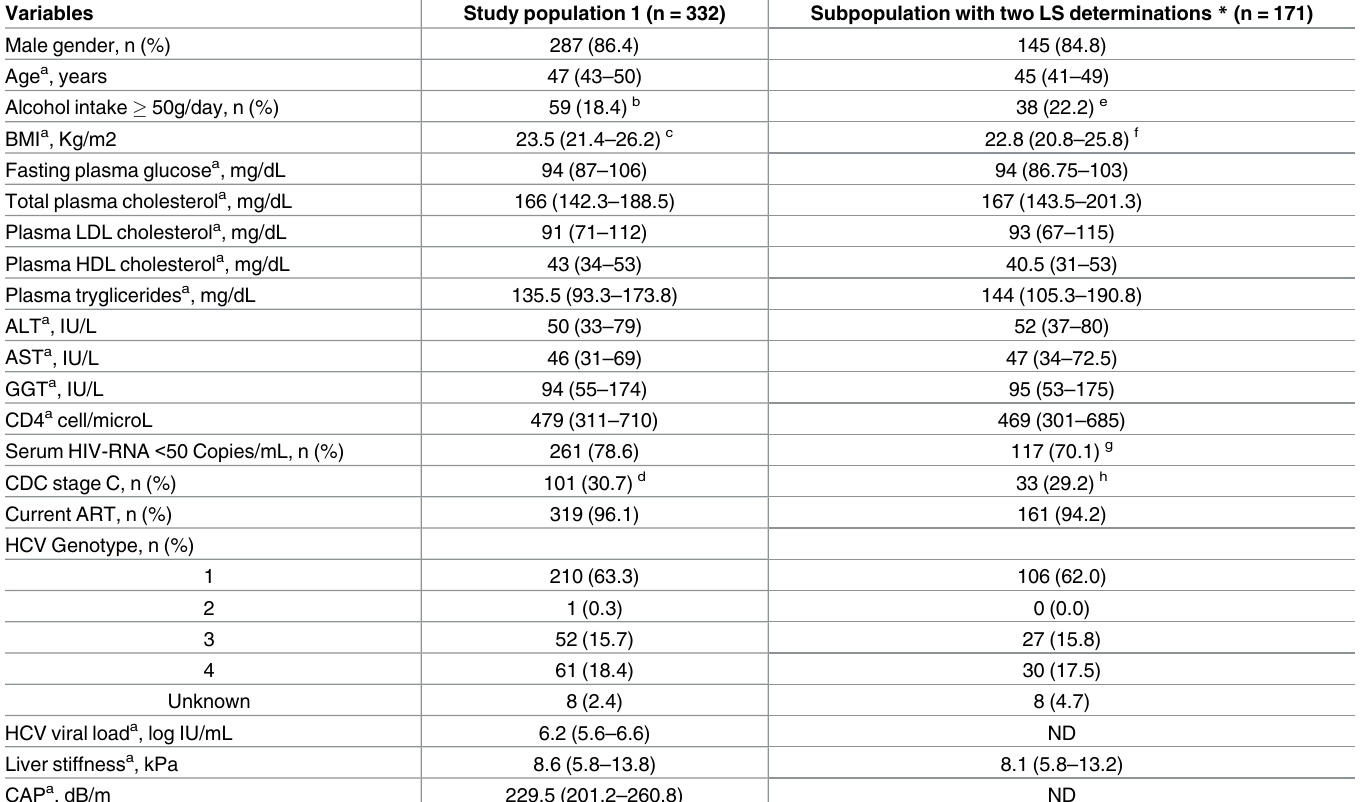
Table 1. Main characteristics of the study population 1 and the subpopulation where liver stiffness progression was evaluated.